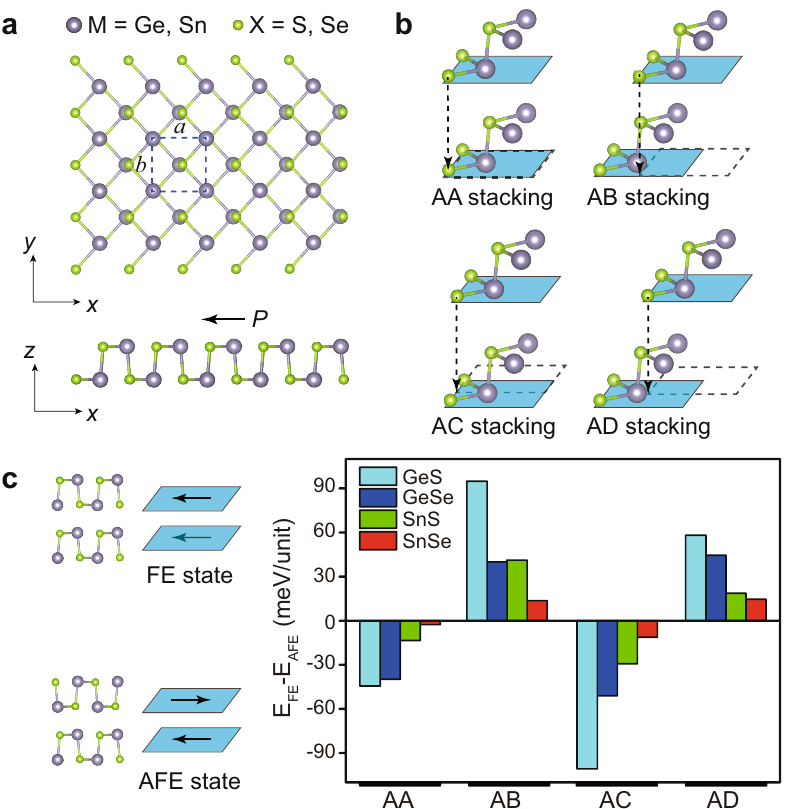
Fig. 1 Bilayer MX ( M = Ge, Sn; X = S, Se) with four different stacking orders exhibiting a ferroelectric (FE) or antiferroelectric (AFE) state. a Monolayer MX crystal structure with a built-in spontaneous FE polarization along the armchair ( x -) direction. b Four high-symmetry stacking orders of bilayer MX . Placing the top layer onto the (0, 0), (0.5, 0), (0, 0.5), and (0.5, 0.5) positions in the x - y plane with respect to the bottom layer leads to the AA, AB, AC, and AD stacking orders, respectively. c The FE polarization of the top and bottom layers can be parallel or anti- parallel, leading to the FE or AFE state, respectively. The total energy differences between the FE and AFE states for bilayer MX are illustrated for the four different stacking orders. For all investigated MX materials, the AA and AC stacking orders prefer the FE state, whereas the AB and AD stacking orders prefer the AFE